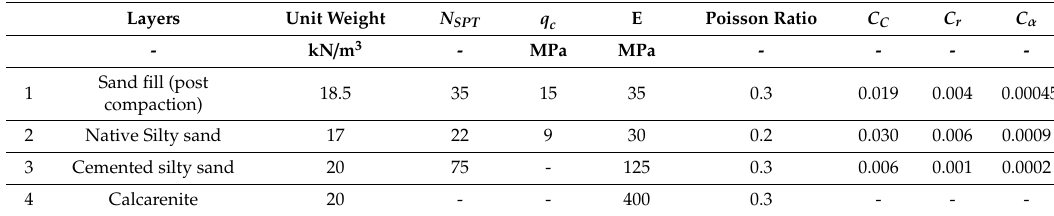
Table 5. Sand fill and natural geotechnical